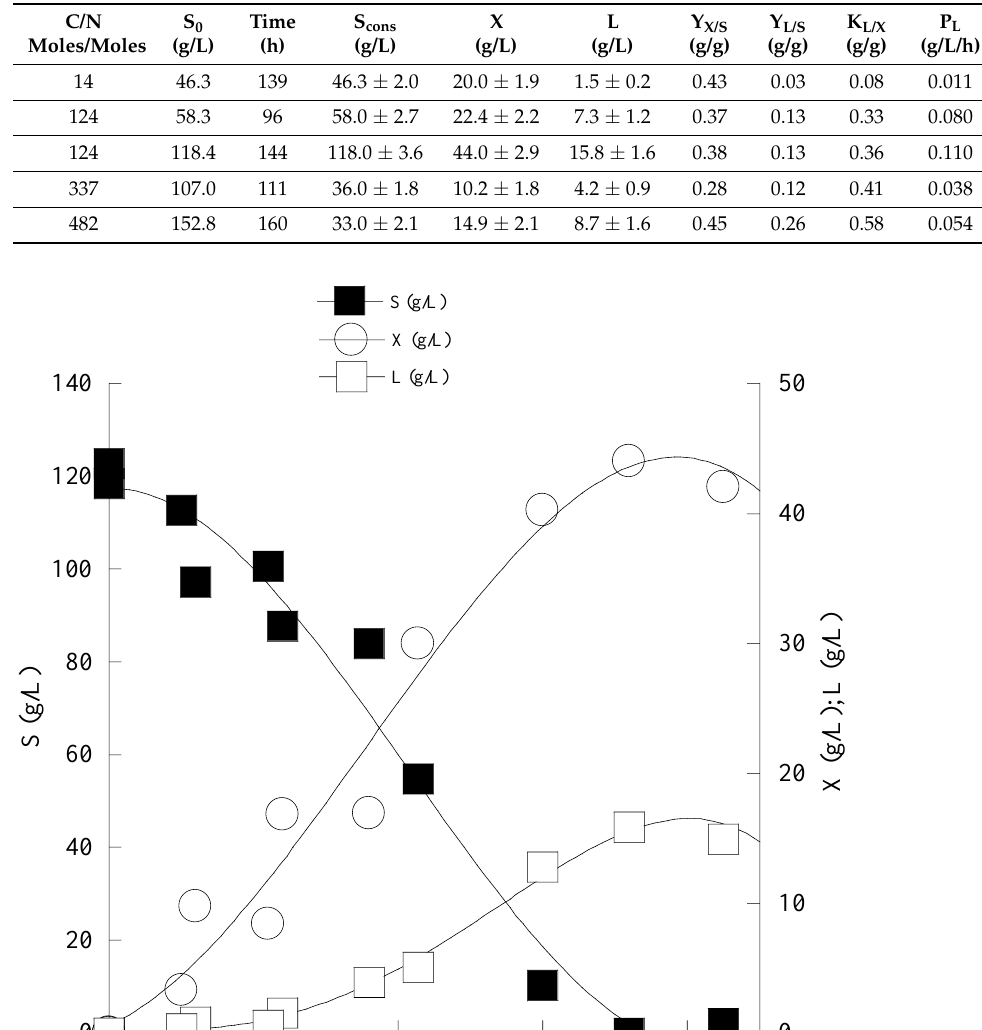
Table 3. Quantitative data originated from kinetics of C. curvatus ATCC 20509, cultivated on a semi-defined medium, with lactose as a carbon source, and various initial lactose (S0) concentrations and C/N molar ratio media. Culture conditions as in Section 2; standard error for most experimental points was ≤ 17%.